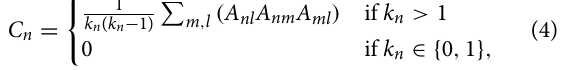
patients (right). Bottom: Relative changes of assortativity ( ¯ a night − ¯ a day ) / ¯ a day during day and night times for each patient. ¯ a day and ¯ a night denote median values of the respective